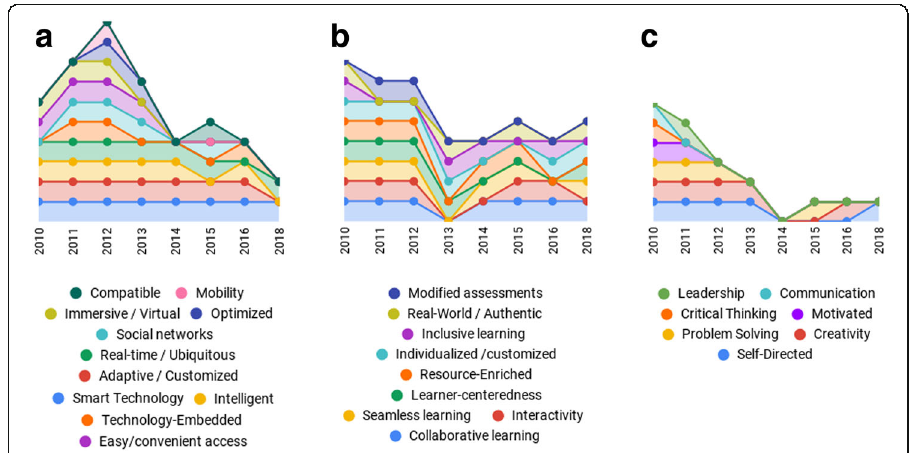
Fig. 5 a Smart learning environments: Keyword lifespan from 2010 to 2018. b Smart pedagogies: Keyword lifespan from 2010 to 2018. c Smart learners: Keyword lifespan from 2010 to